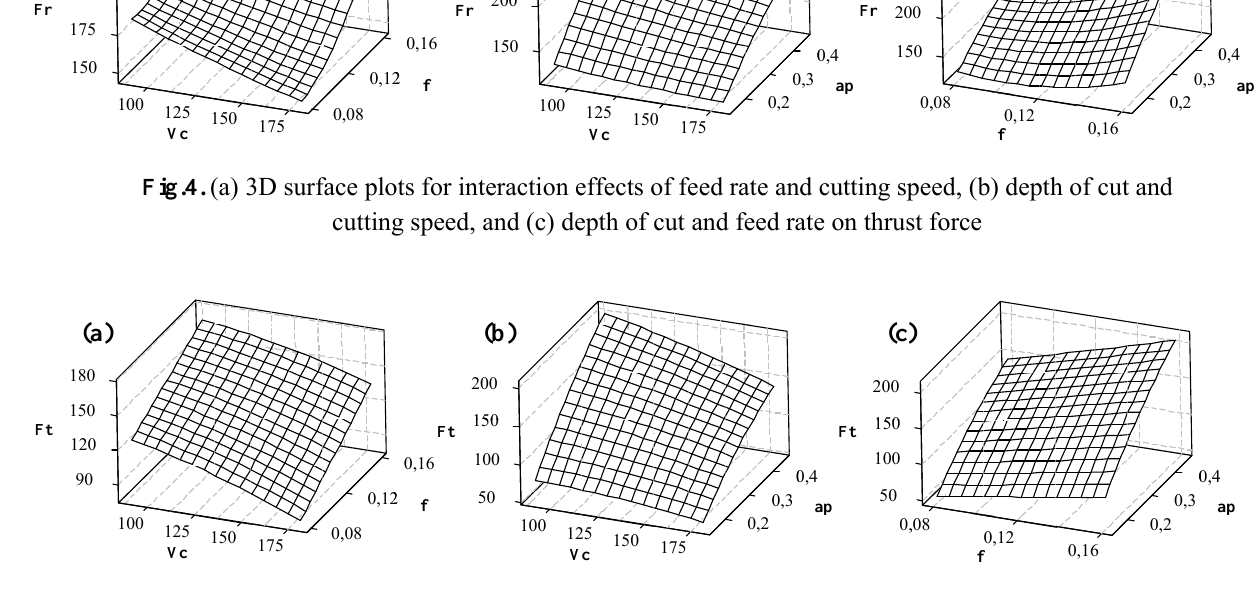
Fig.5. (a) 3D surface plots for interaction effects of feed rate and cutting speed, (b) depth of cut and cutting speed, and (c) depth of cut and feed rate on tangential force